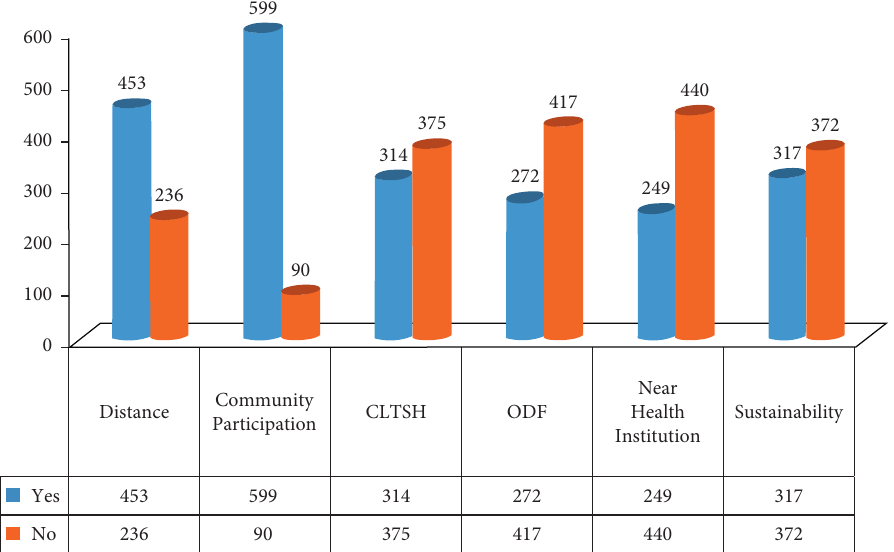
Figure 1: Factors related to sustainability of one WASH facilities in the rural settings of North Shoa, Table 1: Bivariate and multivariate analysis of factors associated with sustainability of one WASH facilities in the rural settings of North Shoa, Ethiopia, November-December 30, 2020. Variables